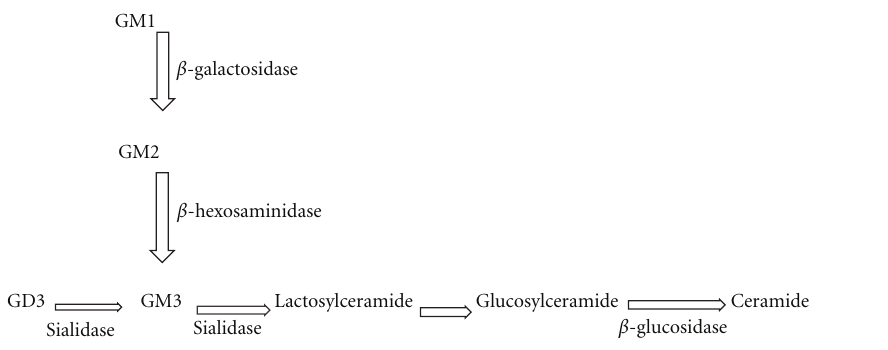
The milk fat globule membrane is a biological membrane enriched in ganglioside that protects and stabilizes milk